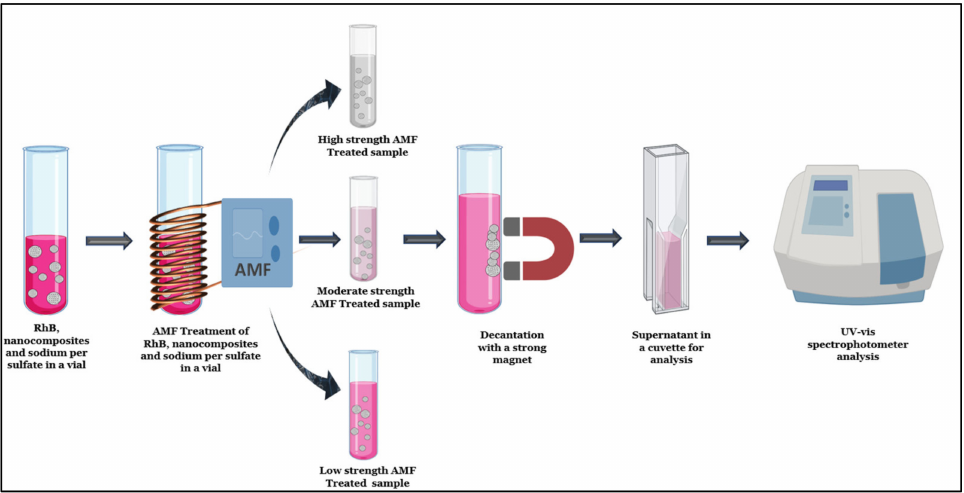
Figure 1. Schematic representation of the AMF treatment with magnetic nanocomposite and sodium persulfate to remove RhB. Created using